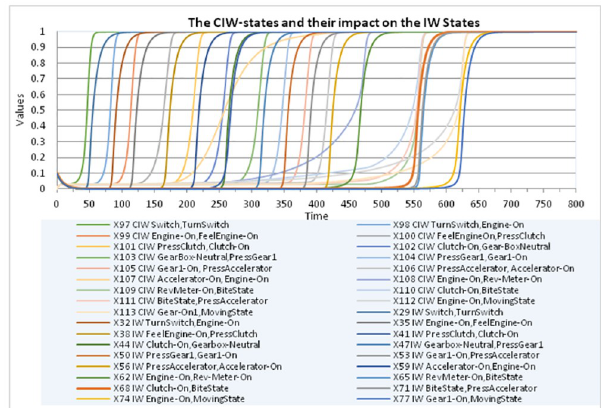
Fig 7. All control CIW-states showing their impact on the corresponding instructional learning IW-states.